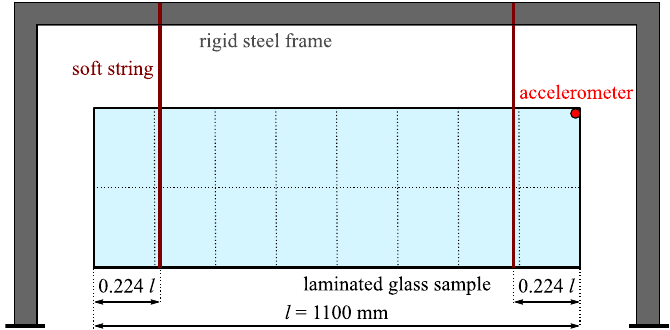
Fig. 3 Experimental setup for modal analysis of laminated glass sample.